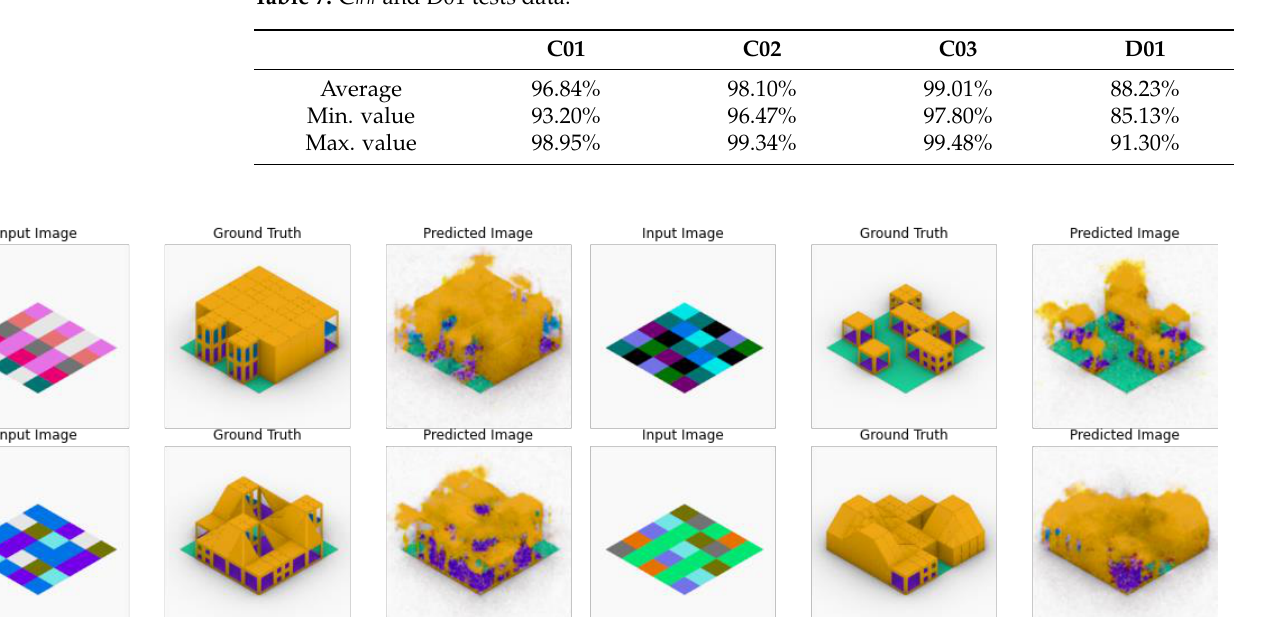
Table 7. C## and D01 tests data.